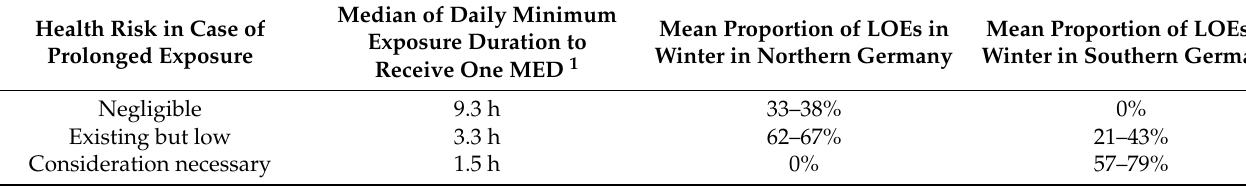
Table 1. Mean proportions (1983 to 2019) of winter LOEs associated with health risks from prolonged UVR exposure in northern Germany (locations: Sylt and Berlin) and southern Germany (locations: Frankfurt and Munich). The term “health risk” is used for reaching the MED for skin type II [67]. The risk levels are given according to [68].